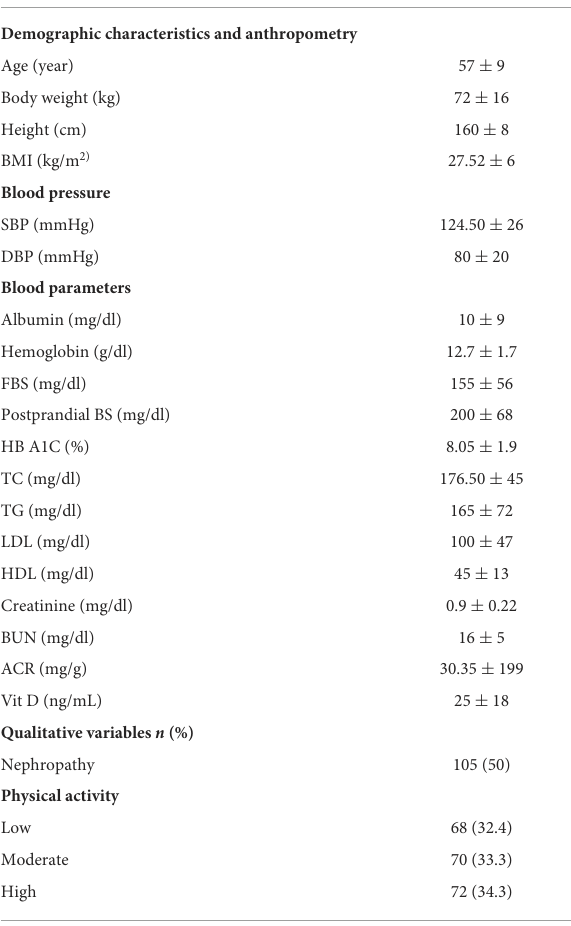
TABLE 1 General characteristics of study